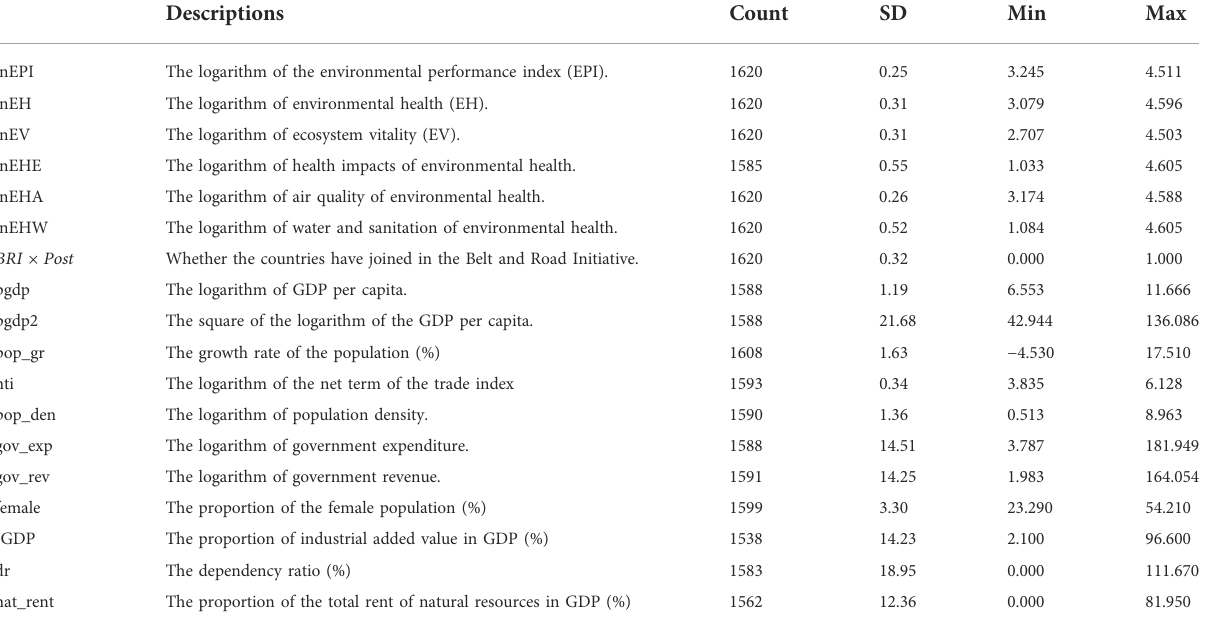
TABLE 1 Summary statistics and variable